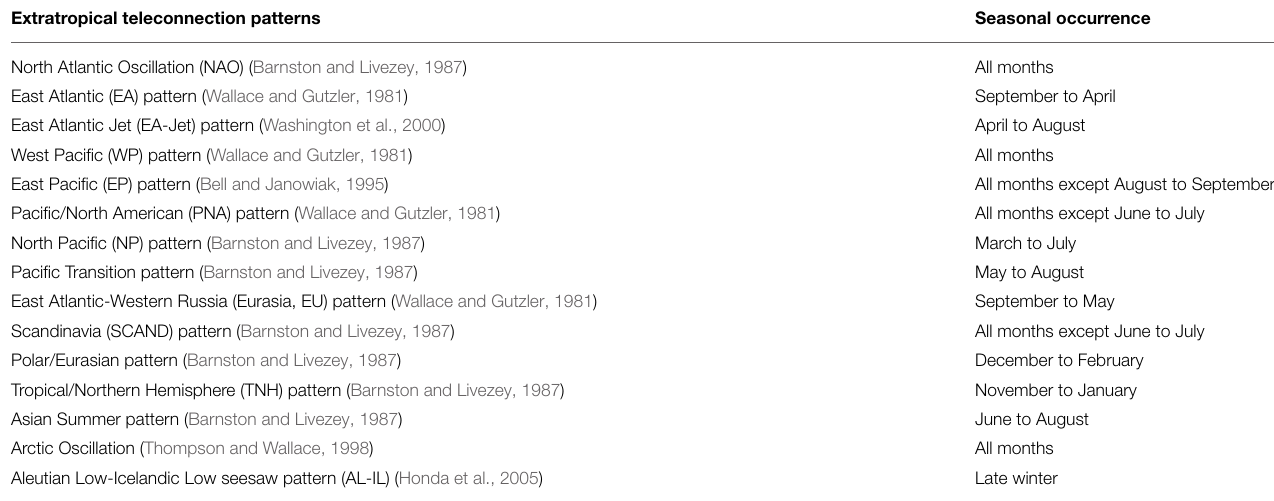
Table adapted from Barry and Carleton (2001, pp. 396–397) showing the names, and acronyms when available, of the major modes of variability in the Northern Hemisphere together with their seasonal occurrence.